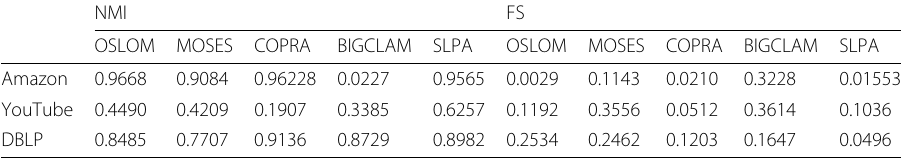
Table 5 NMI and F-Measure (FS) scores of benchmark algorithms on three real-world networks NMI